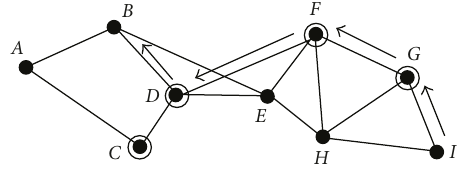
Figure 1: The minimum connected dominating set (MCDS) { C , D , F , G } forms a backbone for the sensor network. A packet is forwarded from node I to node B by the